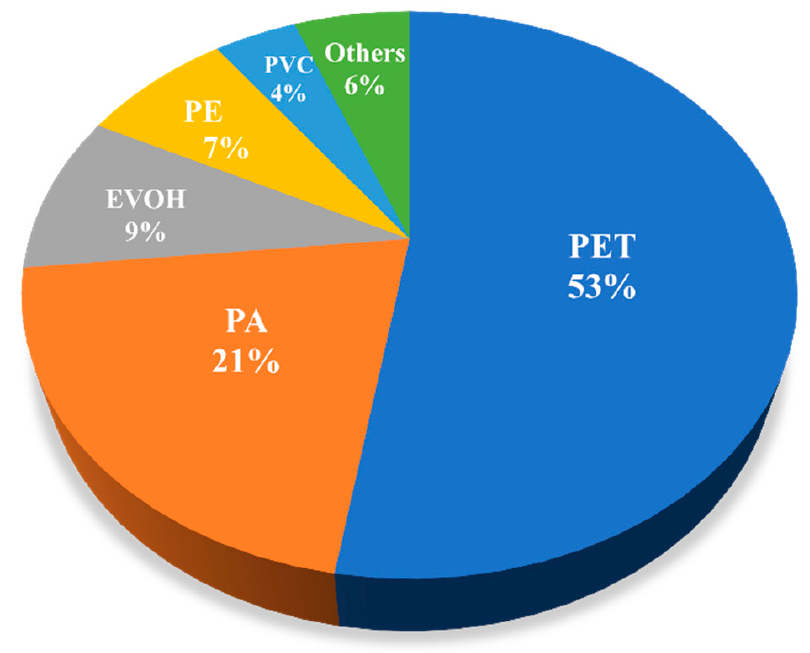
Figure 5. Types of polymers in microplastics in studied rivers.